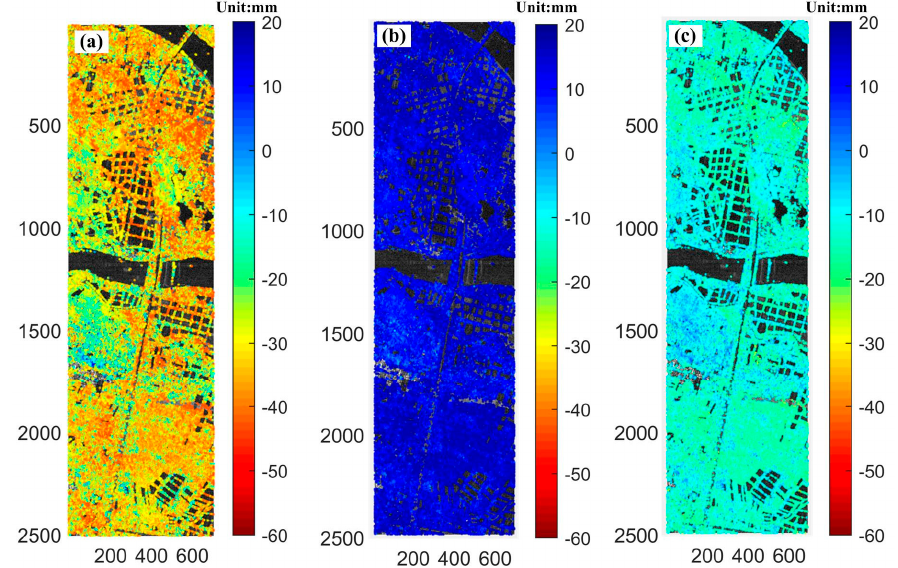
Figure 9. Estimated LOS deformation parameters of CPM: ( a ) Parameter c 1 ; ( b ) Parameter c 2 ; ( c ) Parameter c 3